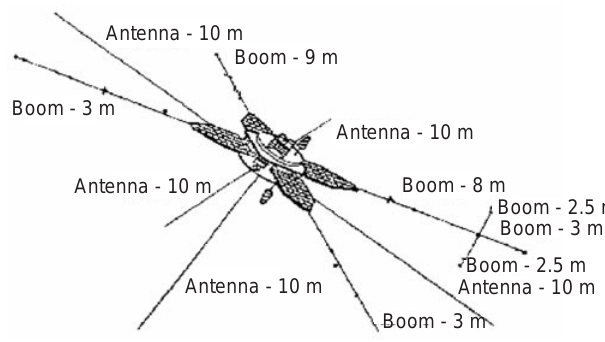
Fig. 1. Structure of the